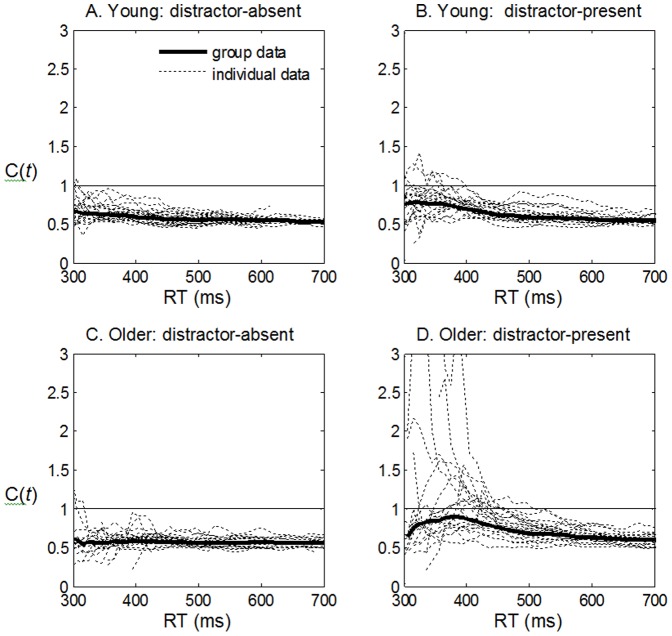
Capacity coefficient for younger and older participants in distractor-present and distractor-absent tasks.The thin dotted lines give C(t) estimates of each individual member of the pertinent group, and the thick solid line gives the group values, aggregated across all group members. C(t)  =  1 is the threshold for unlimited capacity – processing of one channel is unaffected by the presence of another target; C(t)> 1, super-capacity, implies that redundant-targets lead to superior performance; C(t) <1, limited capacity, implies that target processing in one channel is impaired by adding a target in the other channel.